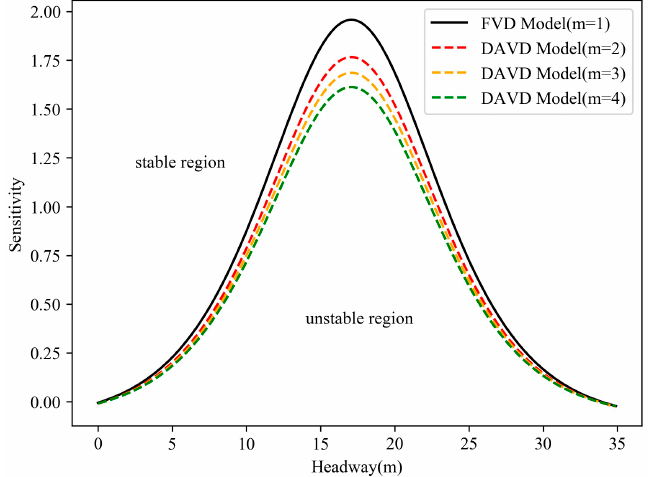
Figure 2. The critical stability curves for different model: the parameters of the full velocity difference (FVD) model are λ = 0.1, β = 0, p = 0; the parameters of the density and acceleration velocity difference (DAVD) model are λ = 0.1, β = 0.05, p = 0.05.